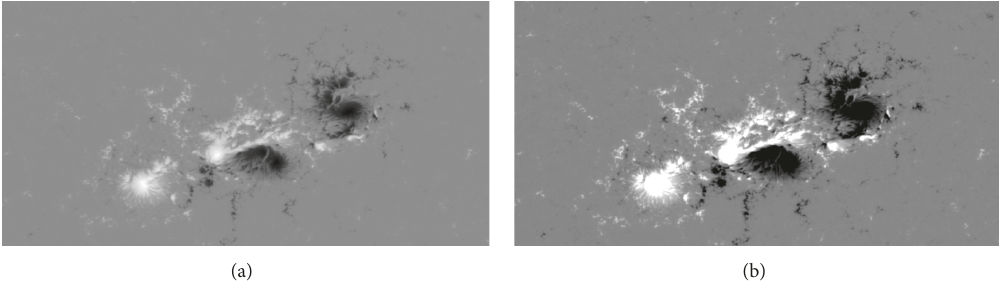
Figure 1: Magnetogram of NOAA 11158 AR (SDO/HMI, February 14, 2011, 22:24 UT). In gray images, white (positive polarity) and black (negative polarity) areas indicate strong magnetic fields, while gray areas show regions of weak magnetic fields. (a) and (b) are unprocessed and processed pictures, respectively.